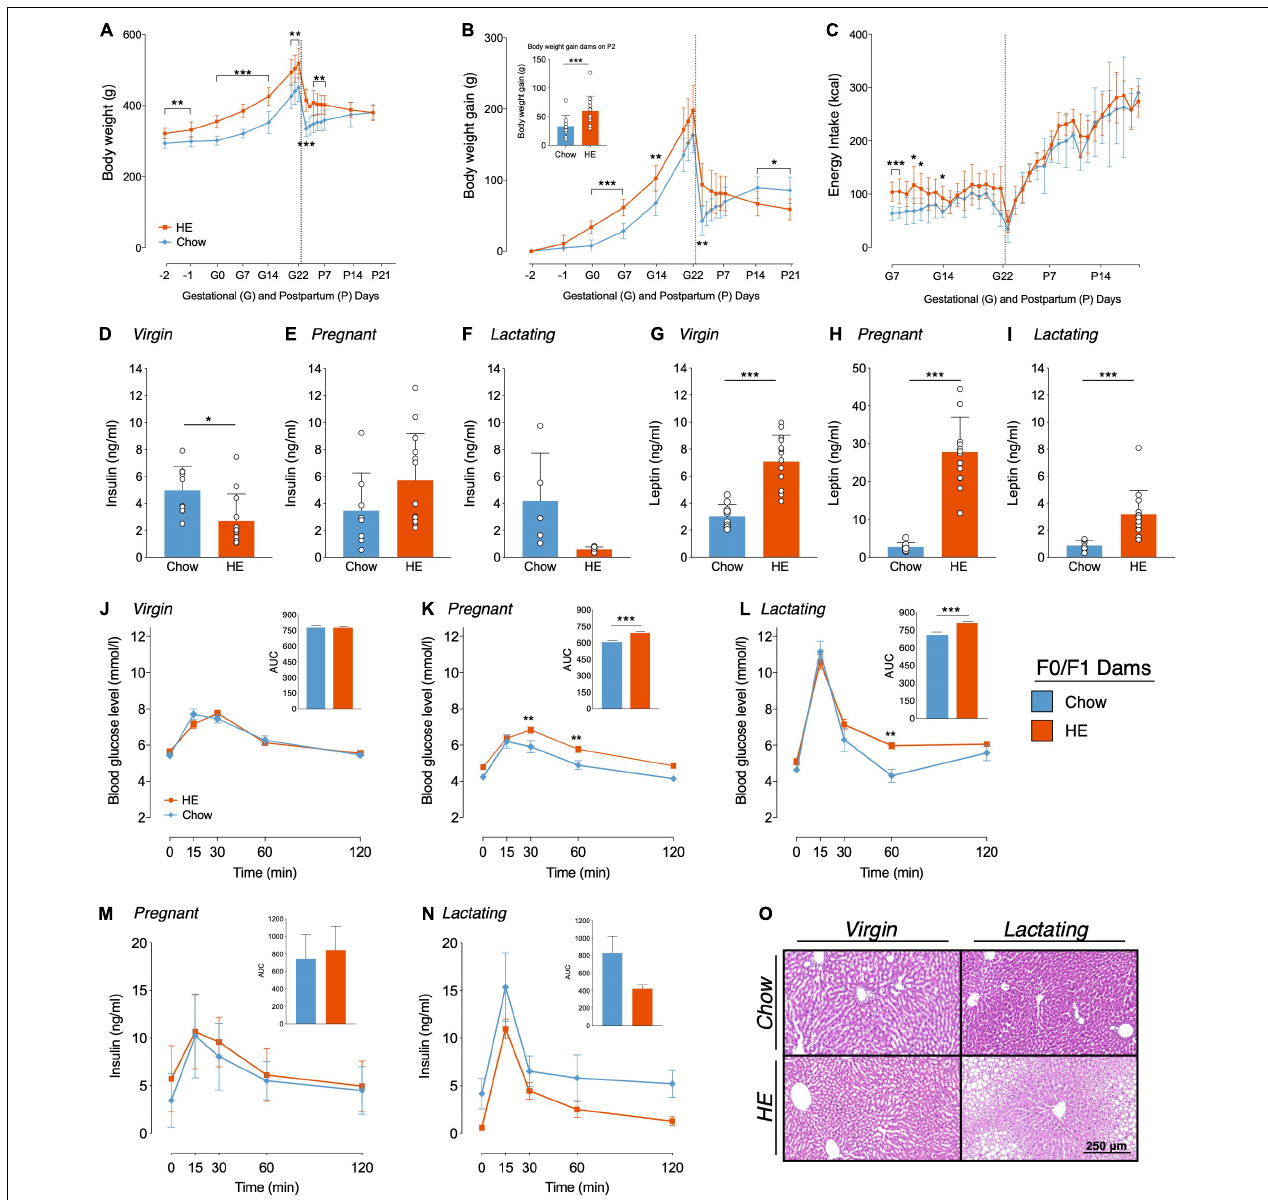
FIGURE 2 | Influence of HE-diet on physiological parameters in obesity-prone and -resistant rat dams in filial generation 0 and 1 (F0/F1) before, during and after pregnancy. Body weight in grams (A) , body weight gain in grams (B) and energy intake in kilocalories (C) of Sprague Dawley dams on chow (blue) or high energy (HE, orange) diet over the course of pregnancy and lactation. Vertical dotted line marks parturition. (B) Inset shows body weight gain during pregnancy (difference between body weight on gestational day 1 (G1) and P2 to account for litter and placenta weight). (D–I) Plasma insulin and leptin levels (ng/ml) following a 12 h fast in dams on chow and HE diet. (D,G) Insulin and leptin levels in virgin dams following a 1 week HE challenge. (E,H) Insulin and leptin levels during mid-pregnancy (gestational day 15). (F,I) Insulin and leptin levels in mid-lactation (postpartum day 12). (J–L) Blood glucose levels (mmol/l) during an oral glucose tolerance test in virgin (J) , pregnant (K) , and lactating (L) dams on chow or HE diet. Inset in each graph (J–L) shows the area under the curve relative to zero. Insulin levels (ng/ml) during the OGTT in pregnant (M) and lactating (N) rats on either chow or HE diet. Insets show area under the curve relative to 0 ng/ml. (O) Representative HE-stained liver sections of virgin and lactating dams on either chow or HE diet (Scale Bar: 250 µ m). Data are represented as mean ± SD. * P < 0.05, ** P < 0.01, *** P < 0.001. N = 10 in chow group, N = 14 in HE group.